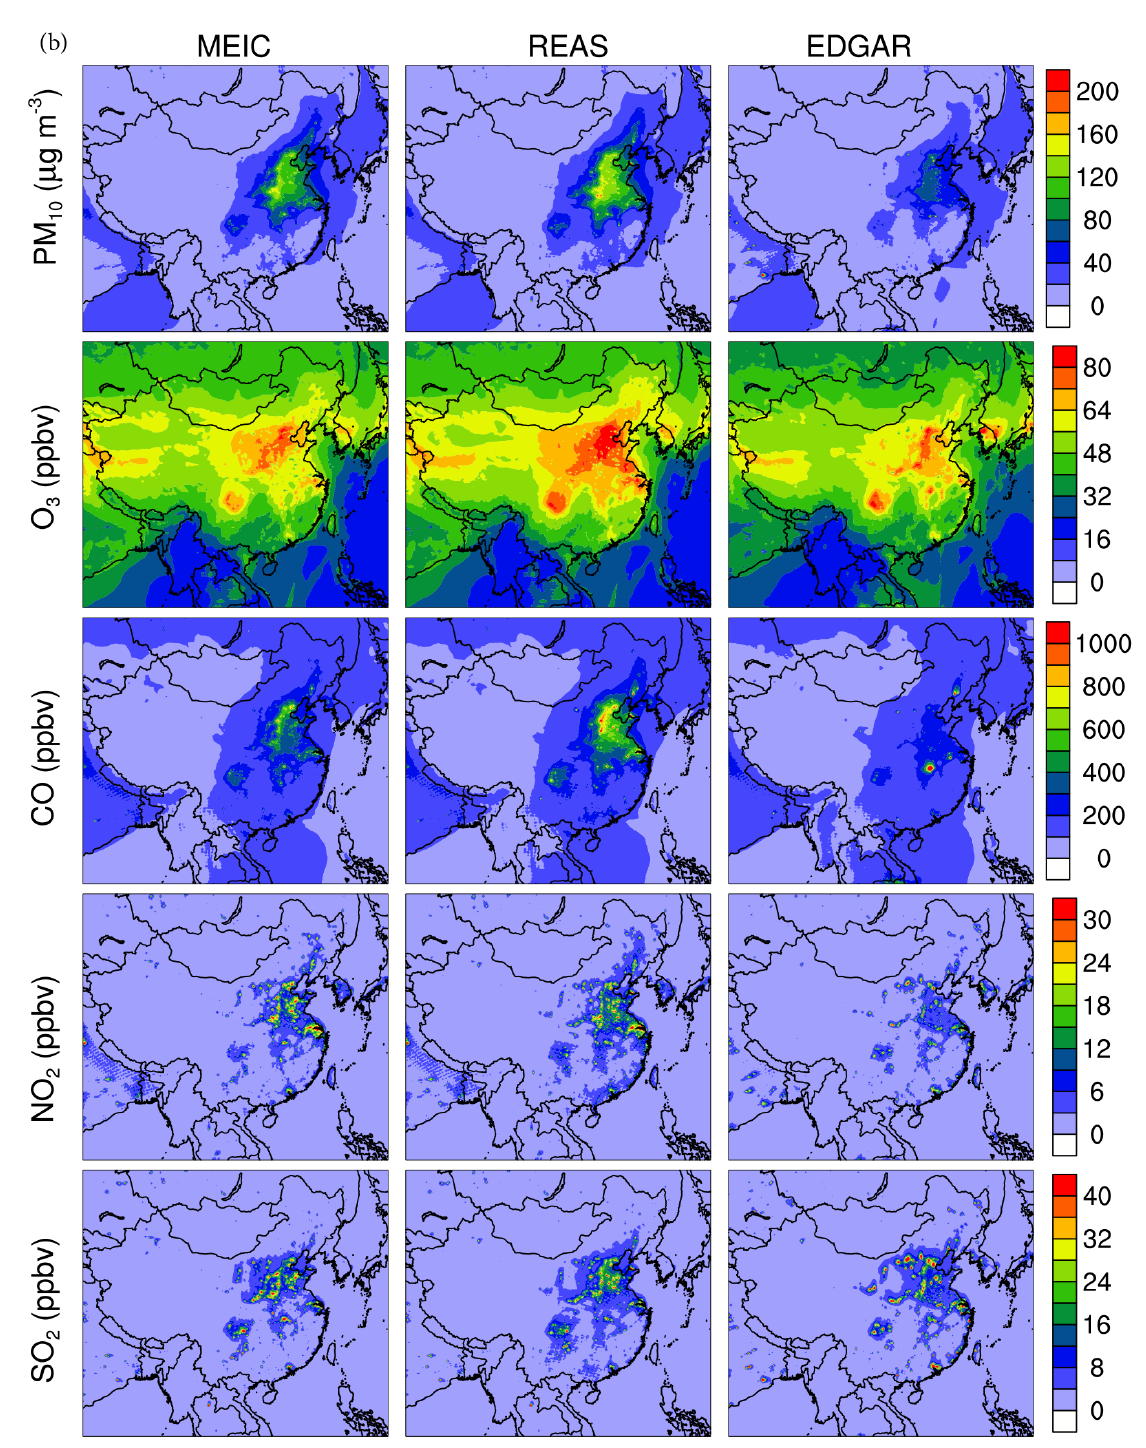
Figure 15. (a) Mixing ratios and concentrations of five pollutants in January using three emissions inventories. (b) Mixing ratios and concentrations of five pollutants in July using three emissions